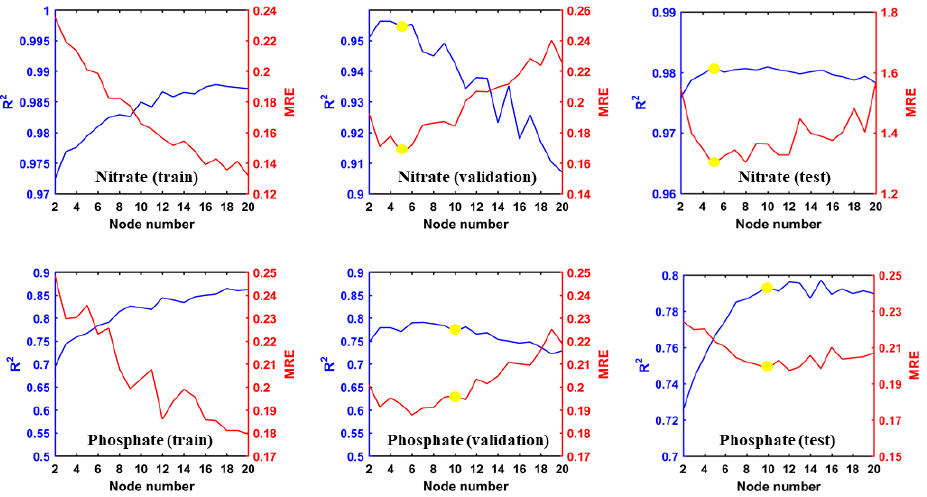
Figure 5. Variation in coefficient of determination ( R 2 ; blue lines) and mean relative error (MRE; red lines) with the number of hidden nodes in the nitrate and phosphate networks. Yellow dots indicate the point when the model achieved stability.